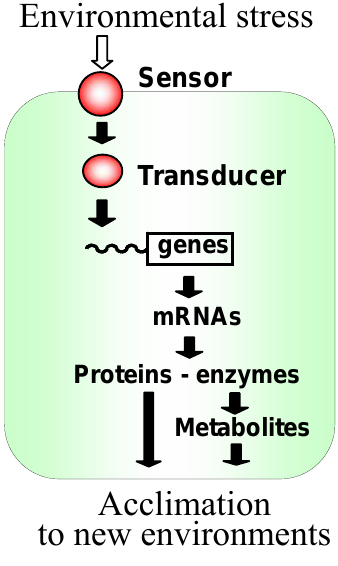
Figure 1. A general scheme showing the responses of a cyanobacterial cell to environmental stress. Adopted from [28]. Published with permission of Horizon Scientific Press / Caister Academic